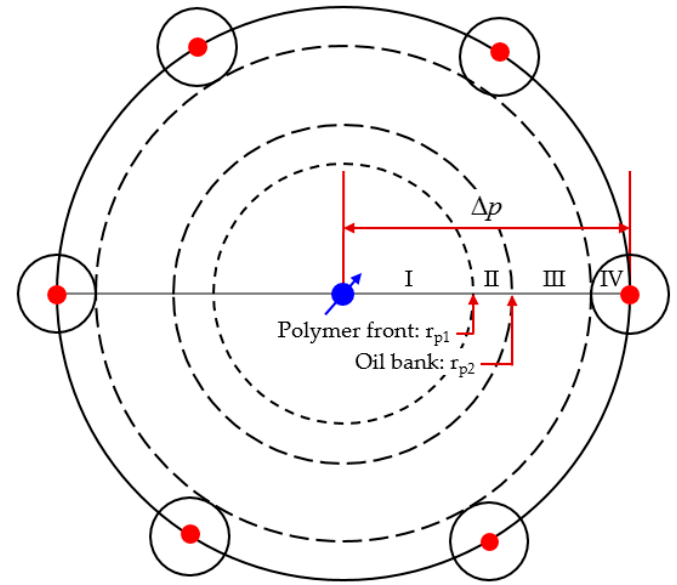
Figure 1. Physical model of polymer flooding in a well pattern (I: Polymer single-phase flow region; II: Oil bank; III: Water–oil two-phase flow region; IV: Oil drainage region).